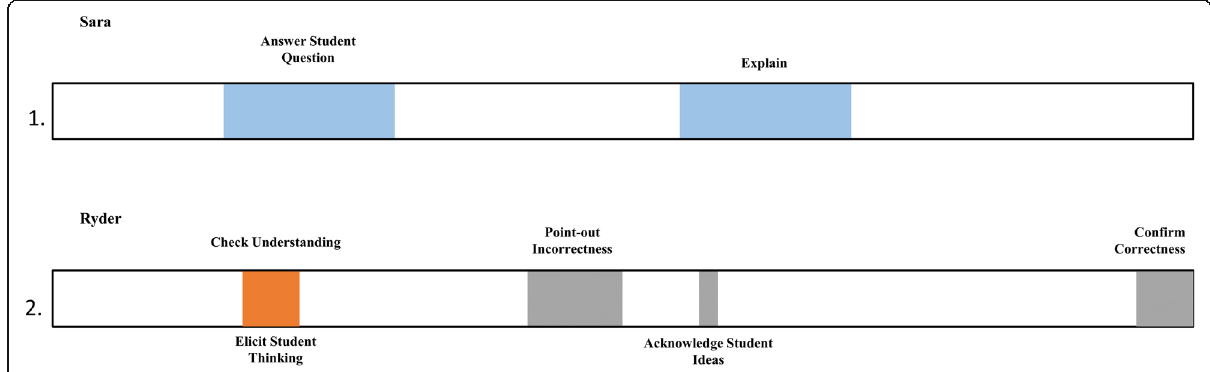
Fig. 5 Timelines of two 2-min interactions between two LAs (Sara and Ryder) and